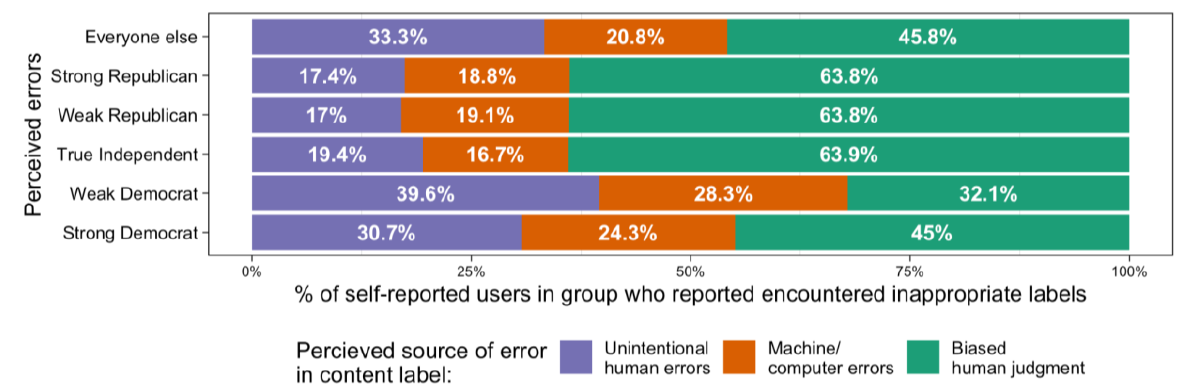
Figure 5. Attribution of label error by party. Percentage of responses ( x -axis) in each error category (colored bar) are shown for each subgroup ( y